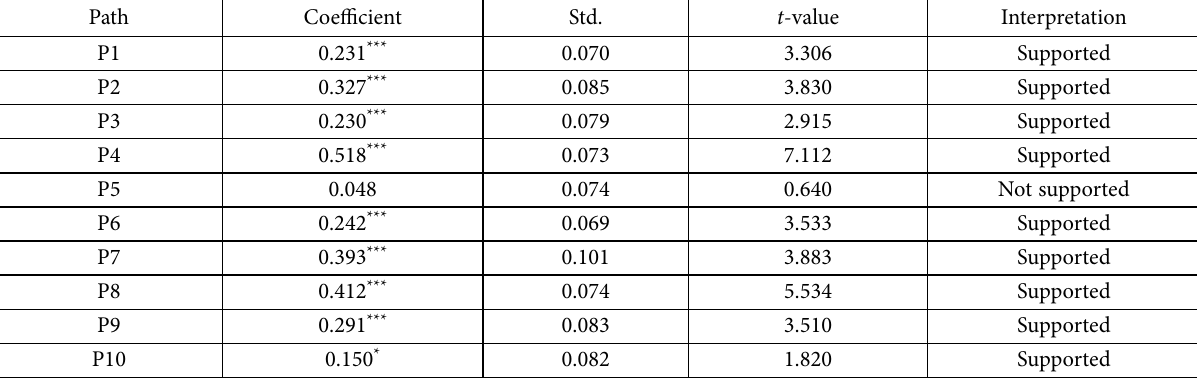
Table 5. Path coefficients and significance